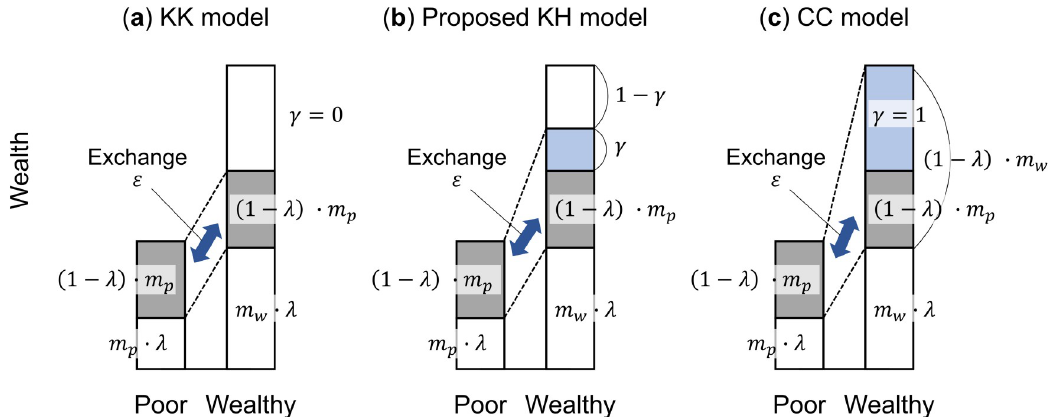
Fig 1. Asset exchange models. (a) Kato and Kudo (KK) model (the surplus contribution rate of the wealthy γ = 0), (b) proposed KH model (a combination of the Chatterjee and Chakrabarti [CC] and KK models (0 � γ � 1), and (c) CC model ( γ = 1).